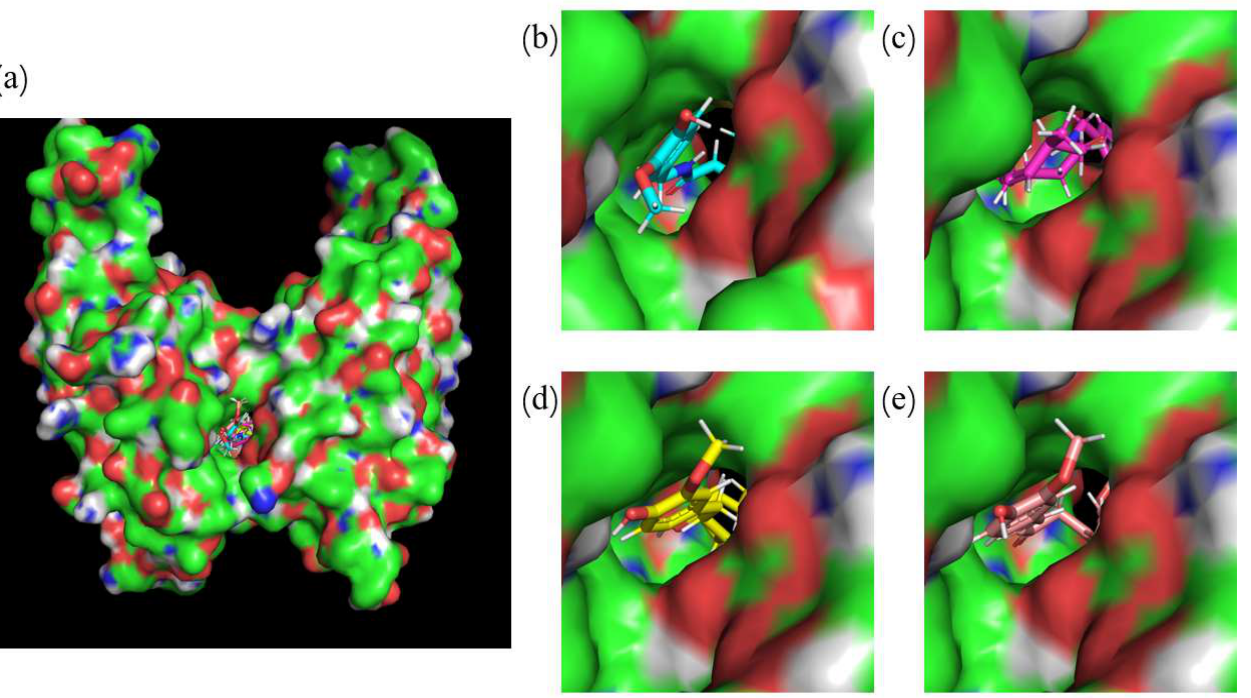
Figure 2. Initial structures of the systems used in MD simulations. ( a ) the binding site of small molecules targeting PD-L1 dimer, ( b ) initial structure of capsaicin, ( c ) initial structure of zucapsaicin, ( d ) initial structure of curcumin, and ( e ) initial structure of 6-gingerol. From the docking results of the PD-L1 dimer with capsaicin, zucapsaicin, 6-gingerol and curcumin, respectively, it can be seen that the binding of the four compounds mainly occurs in the inner channel pocket of the dimer (Figure 2). The studied four food-derived molecules have the similar binding modes with the original ligand (BMS-200), suggesting that the docking protocol could be utilized to identify the binding conformations of the capsaicin, zucapsaicin, 6-gingerol and curcumin systems. Then, the docked complexes were applied as initial coordinates in the following MD simulations. The method of building the initial model is referred to the work of Guo et al. [30], while all the charges of small molecules are calculated as RESP charge, considering that RESP charges are more accurate than BCC in dynamic simulation